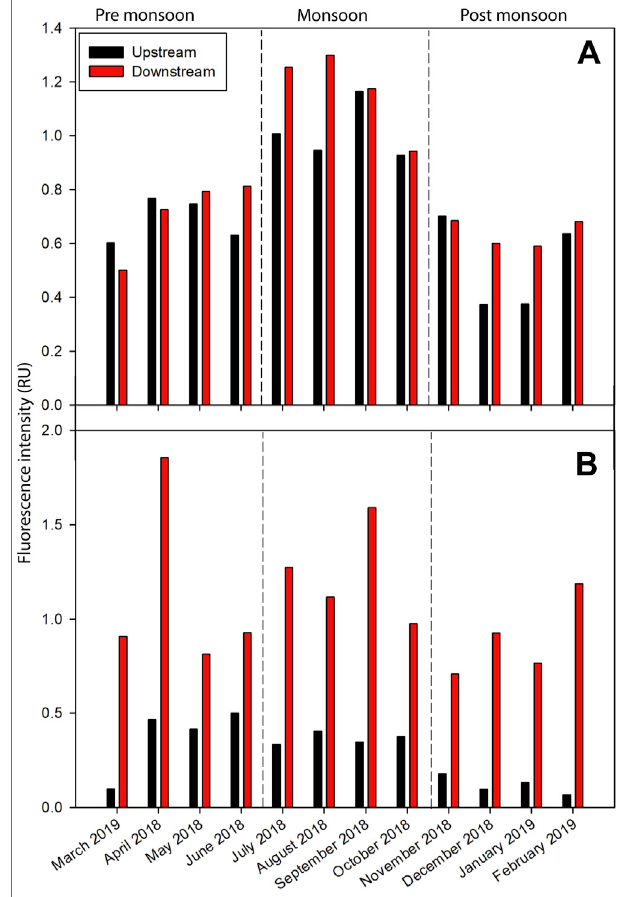
FIGURE 8 | Comparison of DOM intensities between upstream and downstream of (A) Brahmaputra and (B) Ganges rivers. The fl uorescence intensities in the upstream of Ganges and Brahmaputra rivers of Bangladesh were derived from Niloy et al. (2021a) and Niloy et al. (2022).